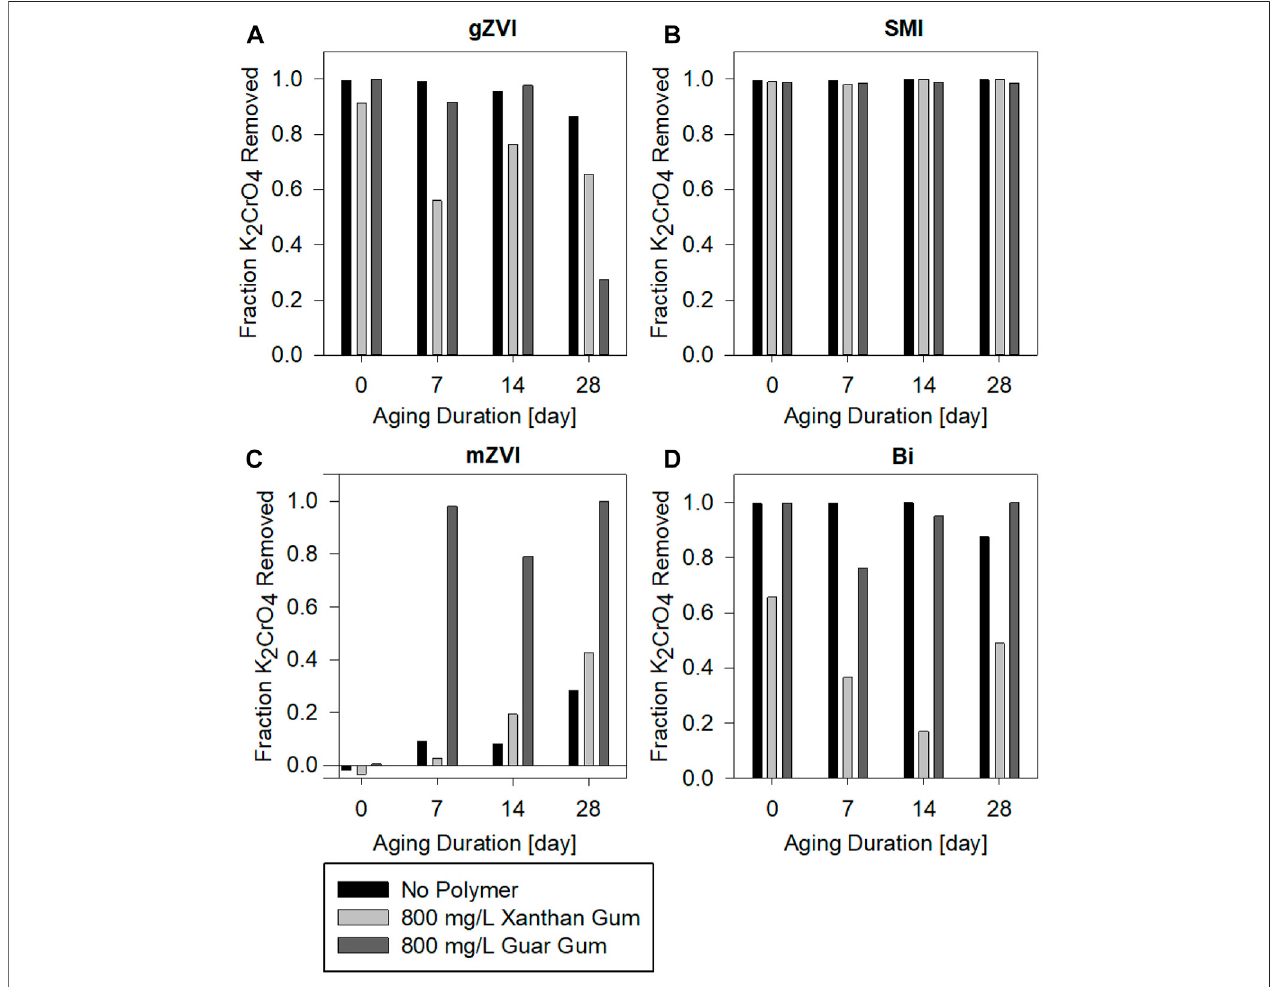
FIGURE3| Effectofpolymer(800 mg/L) – amendmentagingonK 2 CrO 4 removalvia (A) gZVI, (B) SMI, (C) mZVI,and (D) Bismuthsub-nitrate.Postaging,chromate was added to the polymer-amendment system and Cr(VI) concentration was measured after 24 h.